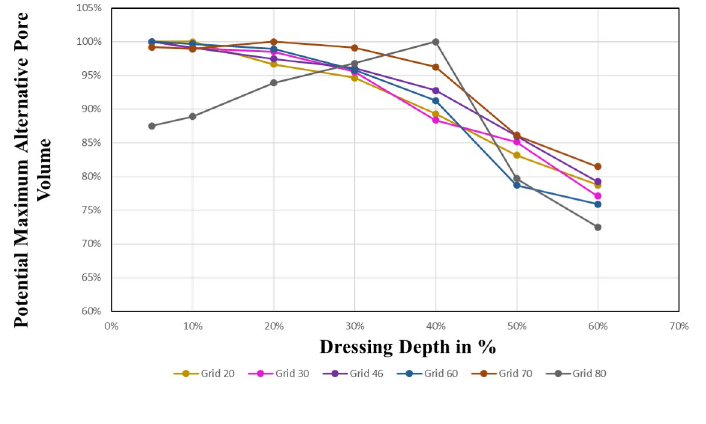
Figure 36. Potential maximum of alternative pore volume dependent on the percentual dressing depth.